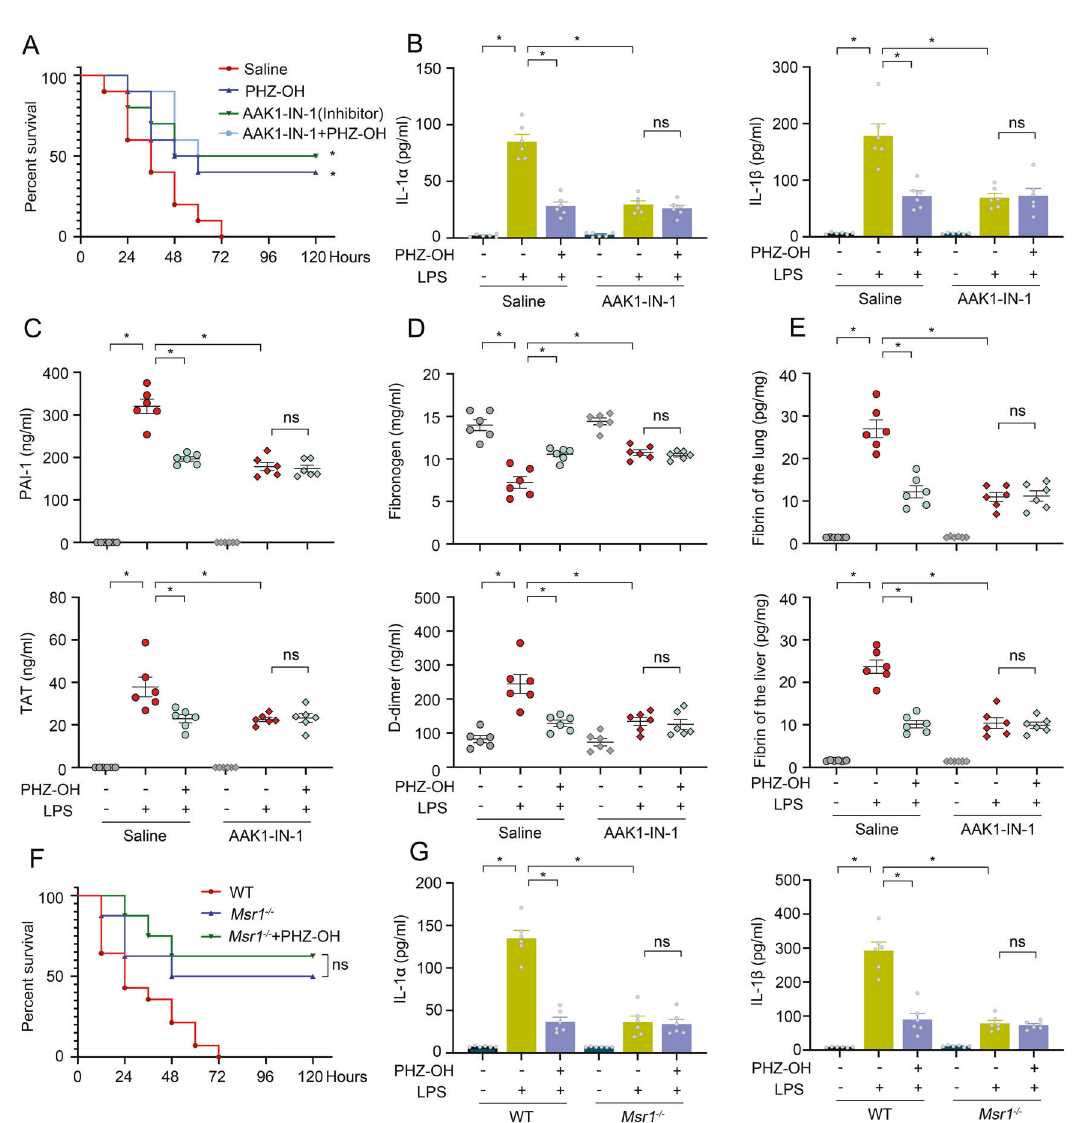
Fig. 8 PHZ-OH alleviates endotoxin-induced coagulation and lethality by inhibiting AAK1. A Survival rate of WT mice treated with PHZ-OH (5 mg/kg) and/or AAK1-IN-1 (5 mg/kg) prior to a challenge of LPS (25 mg/kg); Plasma levels of IL-1 α / β ( B ), PAI-1 and TAT ( C ), and fi brinogen and D-dimer ( D ), and fi brin concentrations of the lung and the liver ( E ) in WT mice primed with LPS (0.4 mg/kg) for 7 h prior to an intervention of PHZ-OH (5 mg/kg) and/or a challenge of LPS (10 mg/kg) for 12 h. F Survival rate of WT and Msr1 − / − mice treated with or without PHZ-OH (5 mg/kg) prior to a challenge of LPS (25 mg/kg); G Plasma IL-1 α / β levels of saline-treated or LPS-challenged (0.4 mg/kg LPS for 7 h and a following 10 mg/kg LPS for 12 h) WT and Msr1 − / − mice under an intervention of PHZ-OH (5 mg/kg) or not. Data are mean ± SEM of six mice in one experiment. * P < 0.05. ns, not signi fi